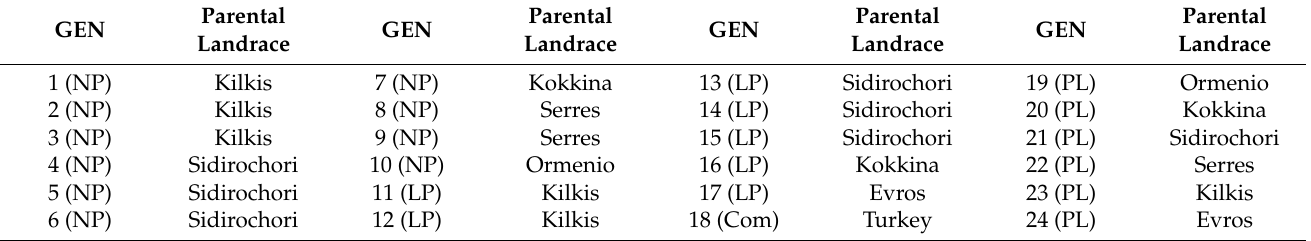
Table 1. List of the 24 sesame genotypes used in the present study. NP: sister line derived from normal planting. LP: sister line derived from late planting. Com: commercial variety. PL: parental landrace. The parental landraces are named after their region of origin. So, our materials are high-rate homozygous lines derived from 5 parental